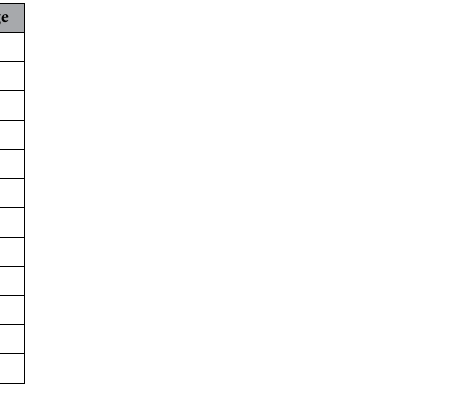
Table 2. Factors of variogram in each input